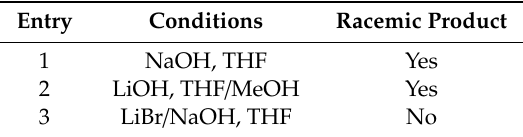
Table 2. Hydrolysis of compound 9 .